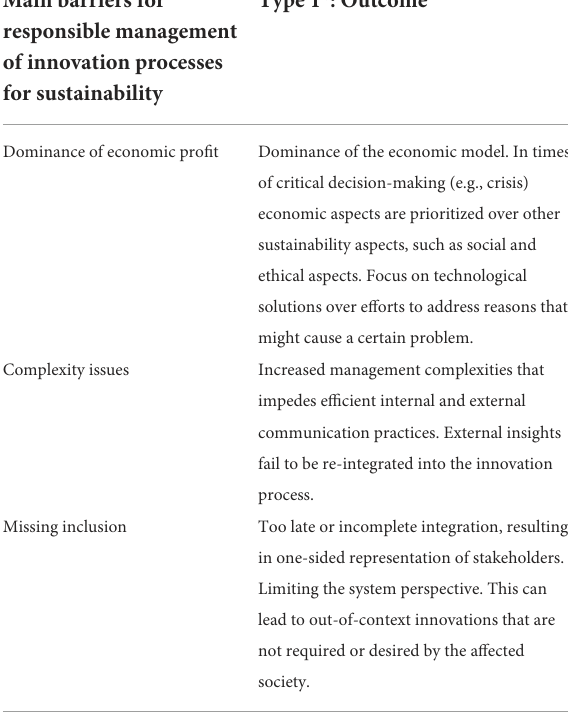
TABLE 4 Shortcomings of SI in terms of responsibility. Main barriers